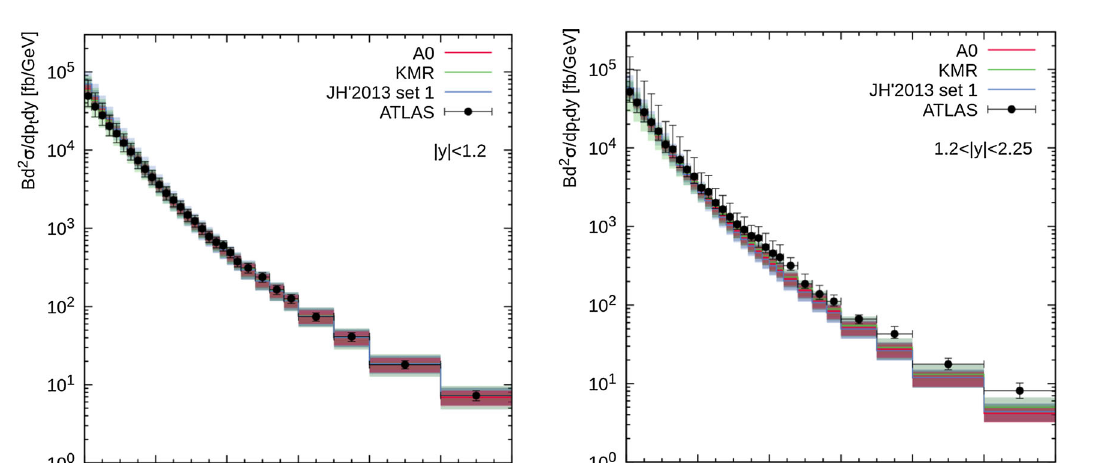
with the A0, KMR and JH’2013 set 1 gluon densities. Shaded bands represent the total uncertainties of our calculations, as it is described in the text. The experimental data are from ATLAS